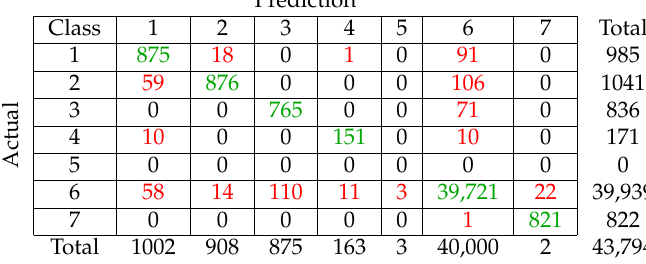
Table 16. Confusion matrix displaying results from the decision tree fin whale classifier, given a new seismic airgun signal class (Class 7). The green highlighted numbers are true positives, and the red highlighted numbers are false positives.